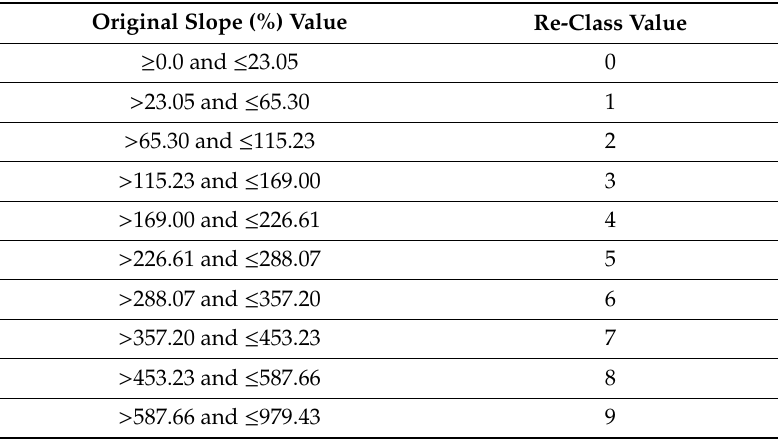
Table 3. Original slope values (%) and assigned re-class values.